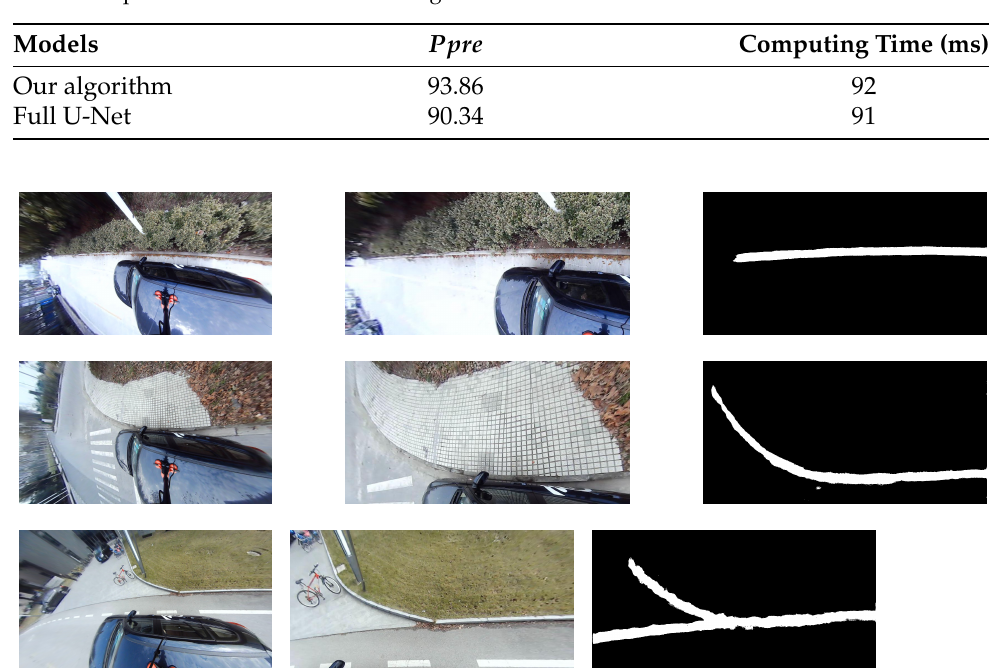
Table 1. Experiment results of semantic segmentation.